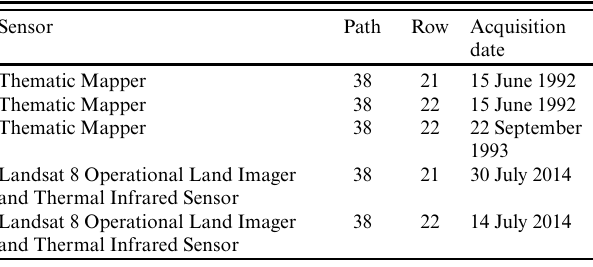
Table 2. Landsat sensor, path and row numbers, and